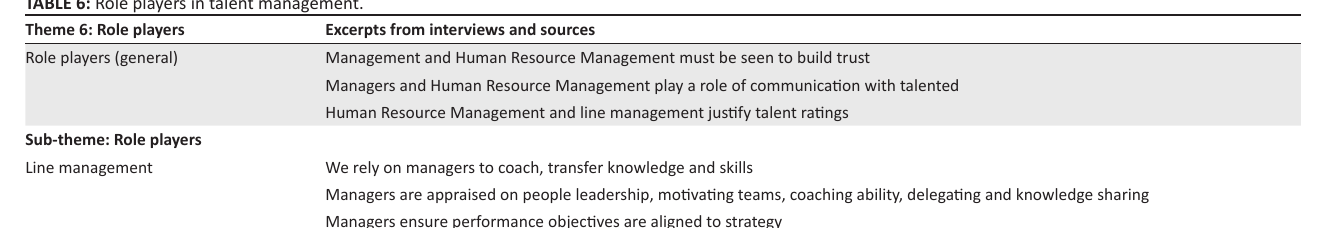
TABLE 6: Role players in talent management.